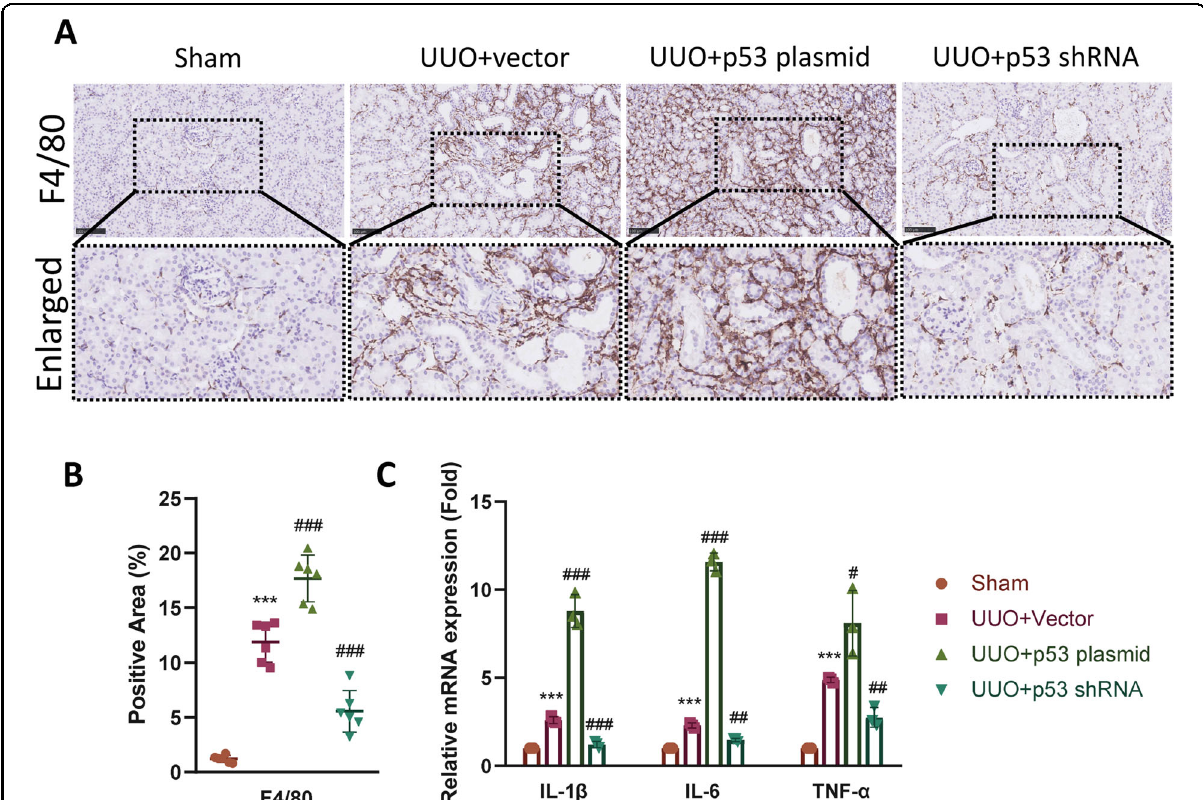
Fig. 7 Regulation of p53 expression changes renal in fl ammation. A Immunohistochemistry staining and enlarged images of F4/80-positive macrophages in the interstitium of sham, UUO + vector, UUO + p53 plasmid, and UUO + p53 shRNA group and B their quanti fi cations. Scale bar = 100 μ m. C Relative mRNA expression of IL-1 β , IL-6, and TNF- α in kidneys from different groups. *** P < 0.001 compared with the sham group. # P < 0.05; ## P < 0.01; ### P < 0.001 compared with the UUO + vector